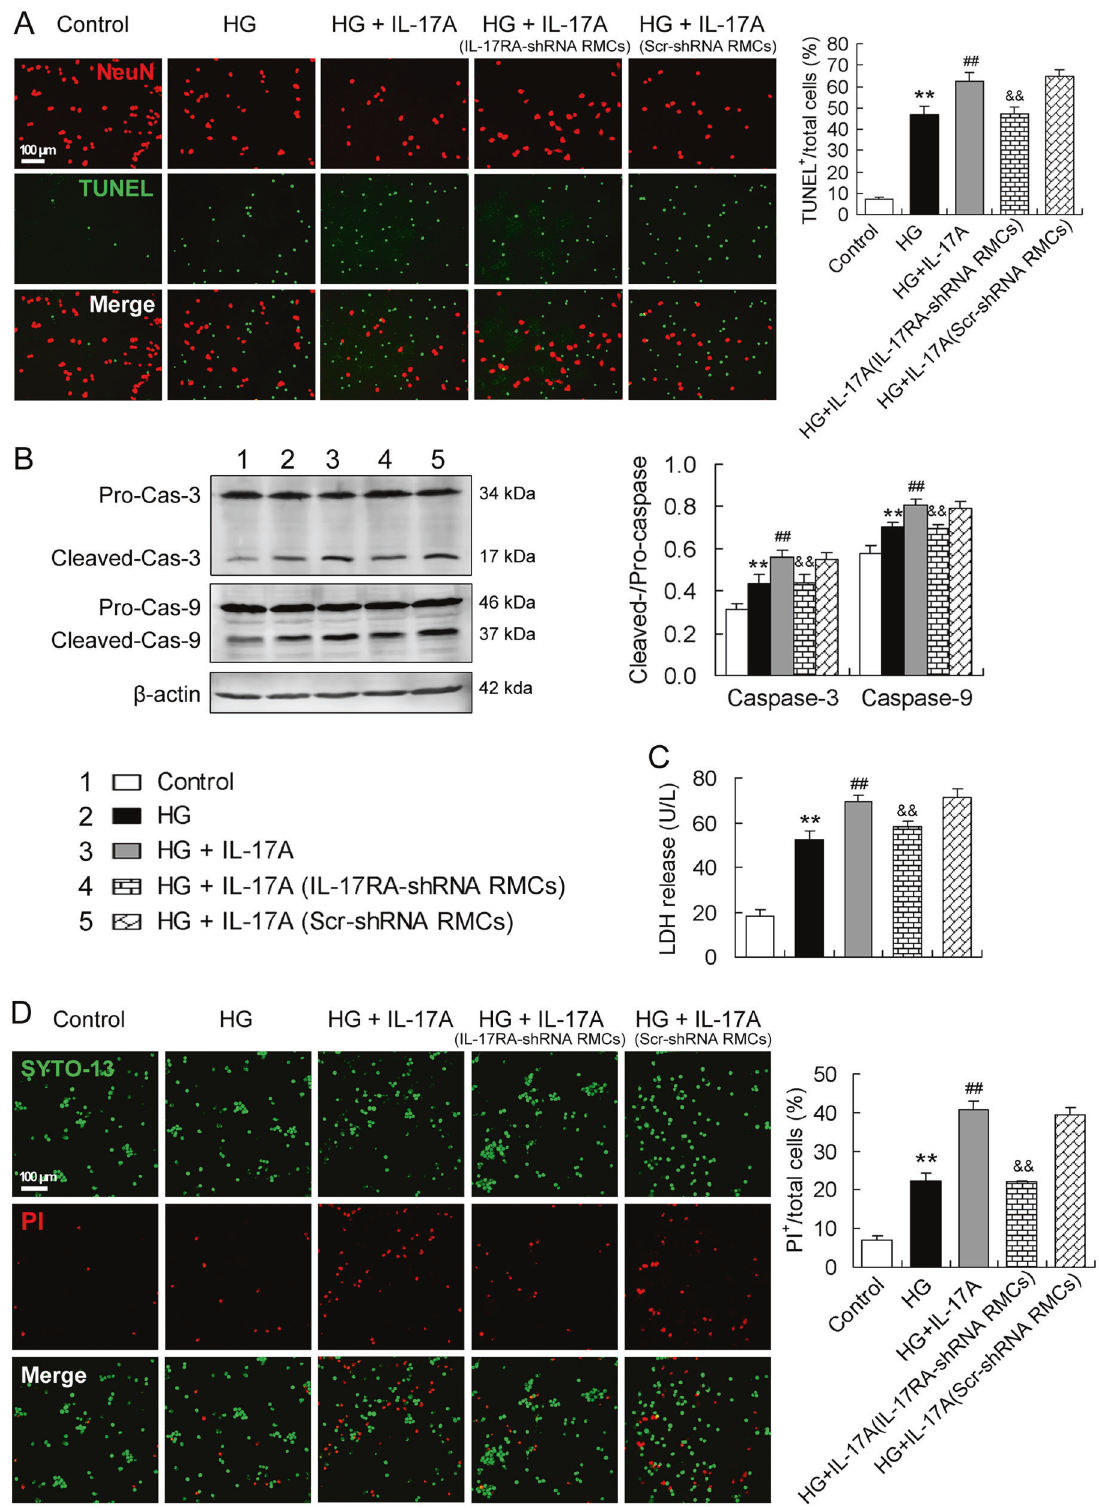
Fig. 6 IL-17A exacerbates HG-induced RGC death in the presence of intact RMCs but not in the presence of IL-17RA-silenced RMCs. Transwell cocultures of RGCs and RMCs that had been treated with IL-17RA-shRNA or Scr-shRNA (as a control) were exposed to IL-17A (50 ng/ml) in HG condition for 24h and the cocultured RGCs were analyzed. A NeuN staining and TUNEL assay of the cocultured RGCs. Apoptosis of the RGCs was assessed by the percentage of TUNEL-positive cells in total cells including NeuN-positive and TUNEL-positive cells. B Active levels of caspase-3 and caspase-9 in the cocultured RGCs. C LDH release levels showing RGC necrosis. D SYTO-13/PI double staining of the RGCs. Percentage of PI- positive cells in the sum of SYTO-13-positive and PI-positive cells was reported in the statistical histogram. All the data in the statistical histograms were from fi ve separate experiments. ** P < 0.01, versus control; ## P < 0.01, versus HG; && P < 0.01, versus HG + IL-17A (Scr-shRNA RMCs).